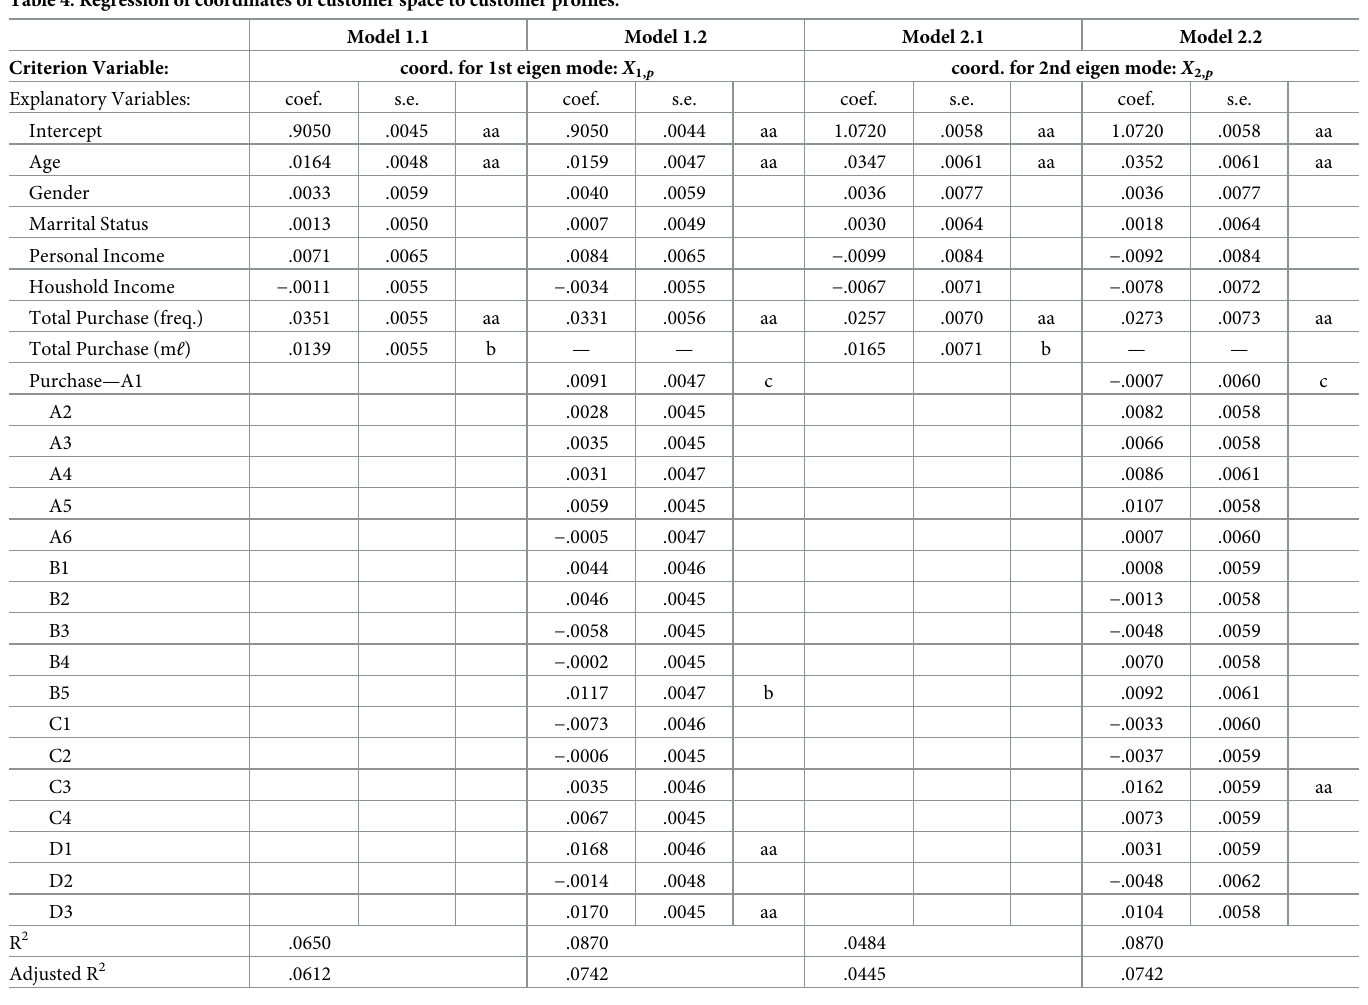
Table 4. Regression of coordinates of customer space to customer